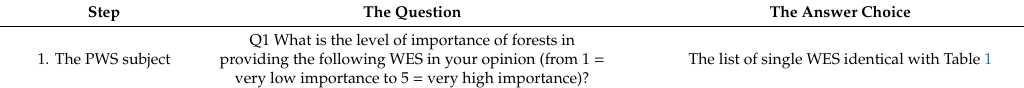
Table 3. The Questions relevant to PWS design in Slovak condition adapted from